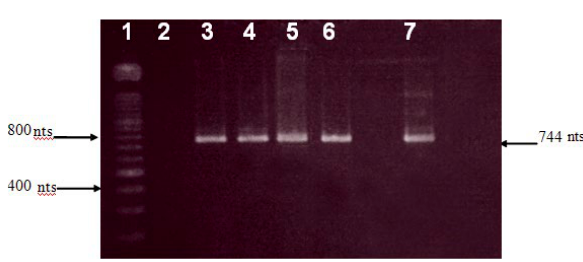
Figure 2. Detection of BYDV-PAV by RT-PCR. Lane 3 = bar- ley from Cap Bon, lane 4 = barley from Bizerte, lane 5 = barley from Kef, lane 6 = barley from Kairouan, lane 7 = positive sample, lane 2= negative control, and lane 1 = 100 nts